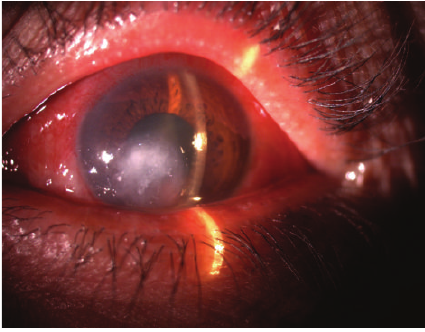
Figure 2: Day 12 since initial examination (Day 1 on Voriconazole).